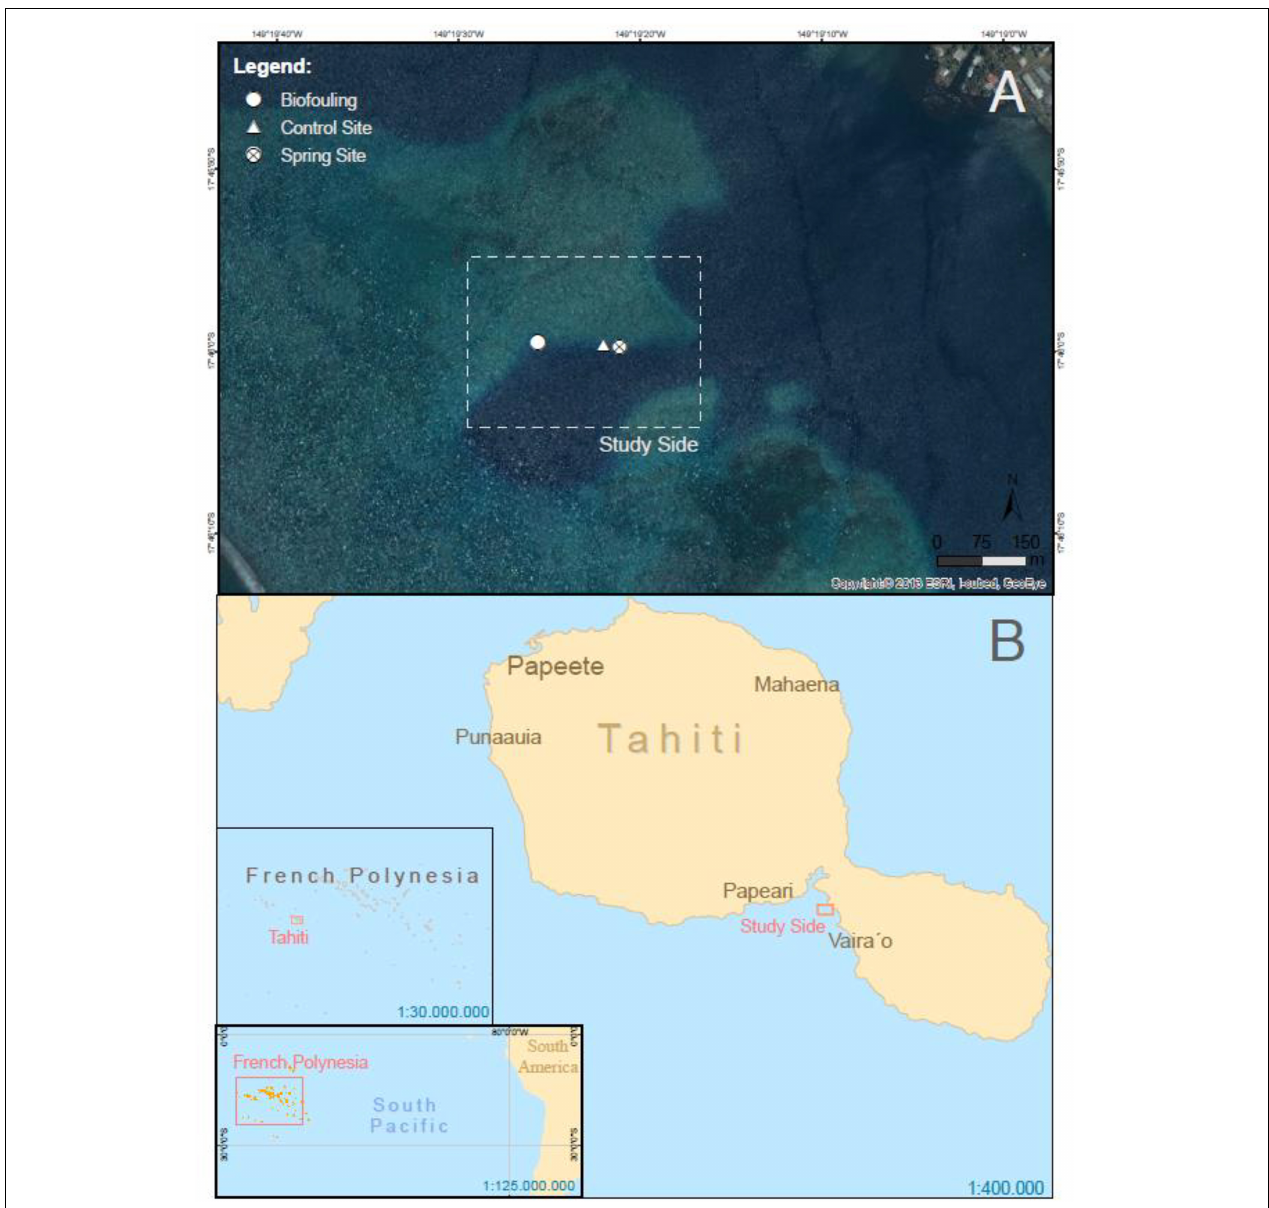
FIGURE 1 | Location of Tahiti, French Polynesia (B) and sampling site (A)